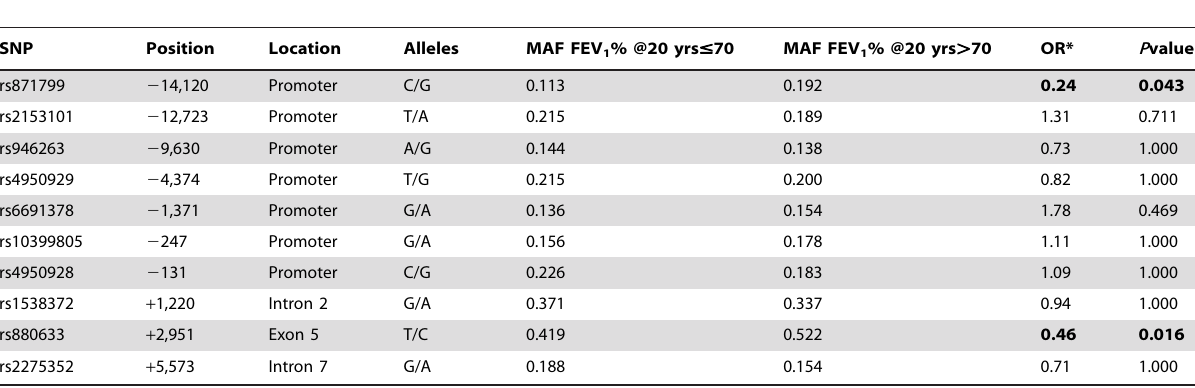
Table 2. Association test results for YKL-40